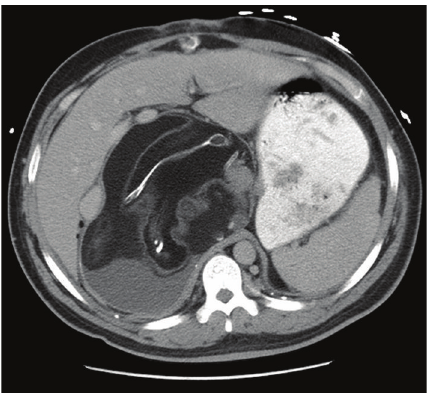
Figure 1: CT scan superior to the umbilicus shows a large, right- sided retroperitoneal mass with bone and soft tissue.